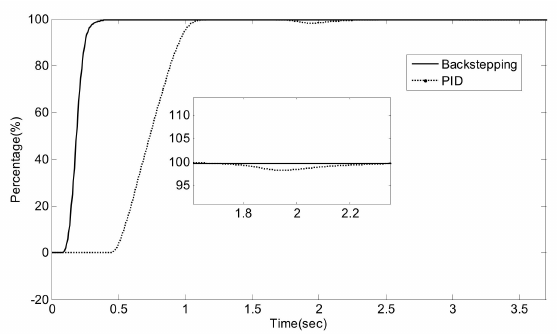
Figure 15. NO / NO 2 = 1 / 0, NOx conversion e ffi ciency.